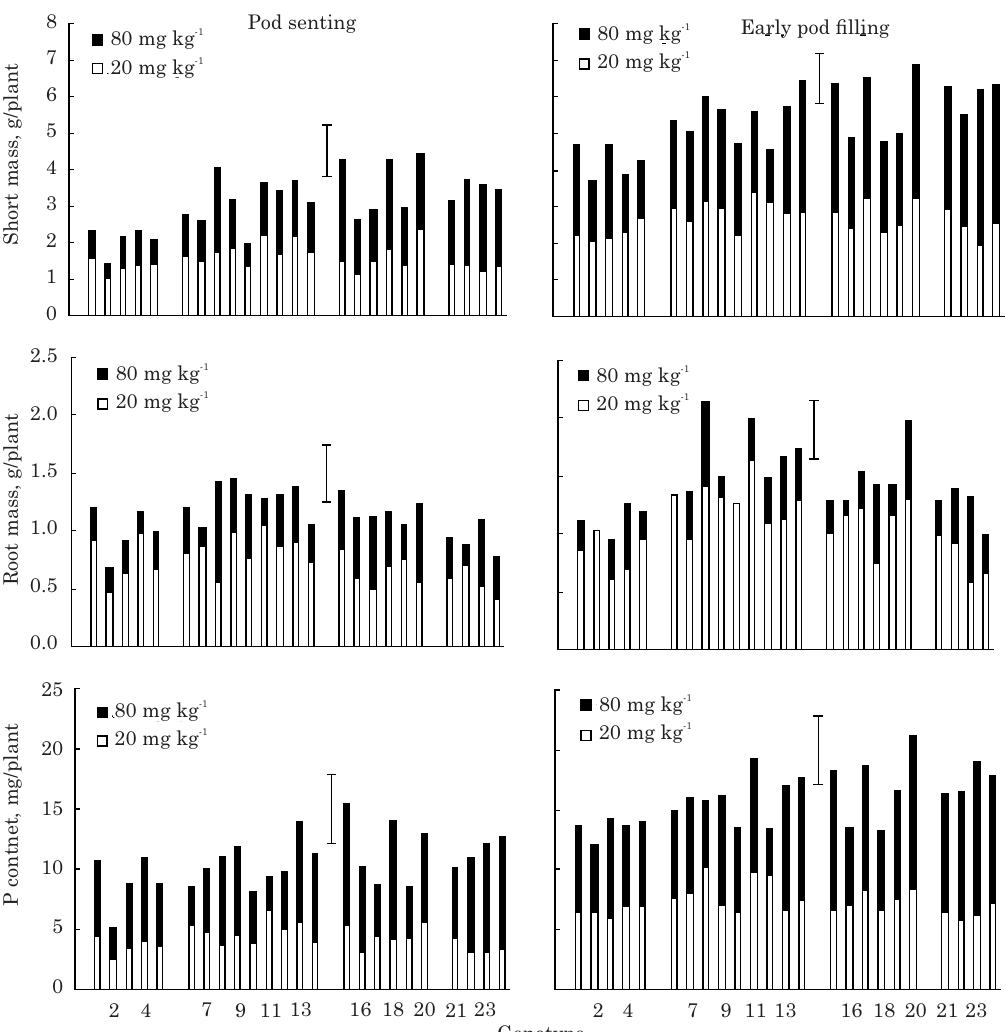
Figure 1. Shoot mass, total root mass (including nodules), and total P content accumulated by the plant, for 24 common bean genotypes grown at two P levels applied to the soil (20 and 80 mg kg -1 ), and at two growth stages (pod setting and early pod filling); vertical bars represent the least significant difference by the Tukey test at 5 % and compare genotypes within each P level. Genotypes: 1 Constanza, 2 Goiano Precoce, 3 Iraí, 4 Pop 59, 5 Pop 71, 6 BAT 477, 7 Guapo Brilhante, 8 ICA Pijao, 9 Jalo EEP 558, 10 Manteigão PC, 11 Rico 23, 12 Rio Tibagi, 13 Safira, 14 Xodó, 15 Aporé, 16 Capixaba Precoce, 17 Carioca, 18 Flor de Mayo, 19 Ouro Negro, 20 Puebla 152, 21 CF 840694, 22 CF 840704, 23 G 12896, 24 G